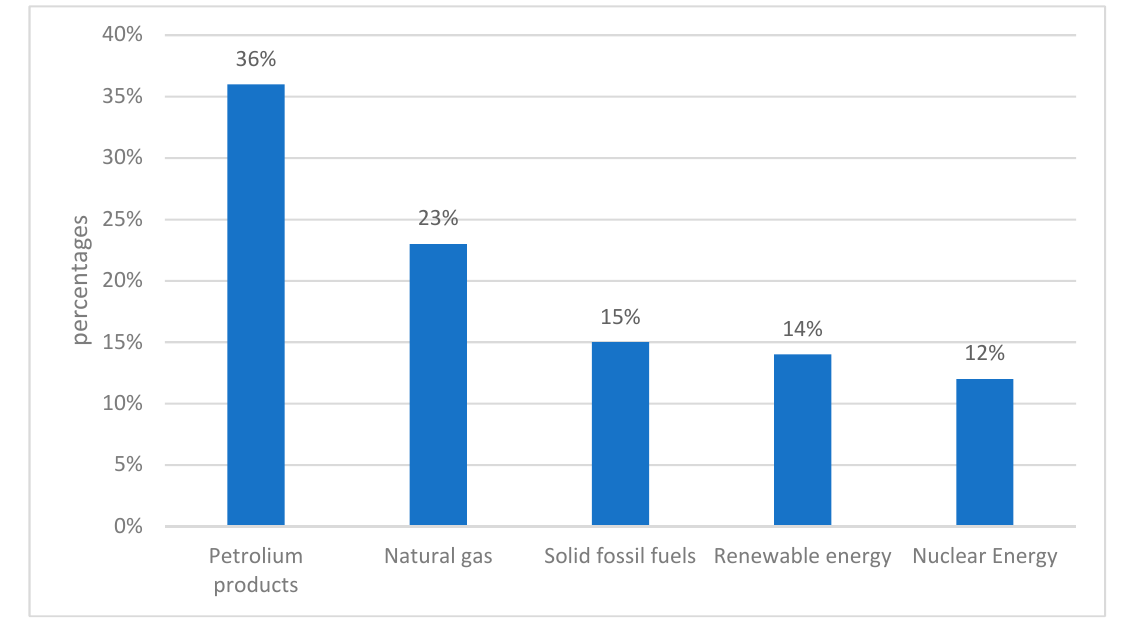
Figure 1. Energy produced in the EU in 2019, by source of energy. Source: authors’ own computations on the data collected from European Union Statistical Office (Eurostat) [9].